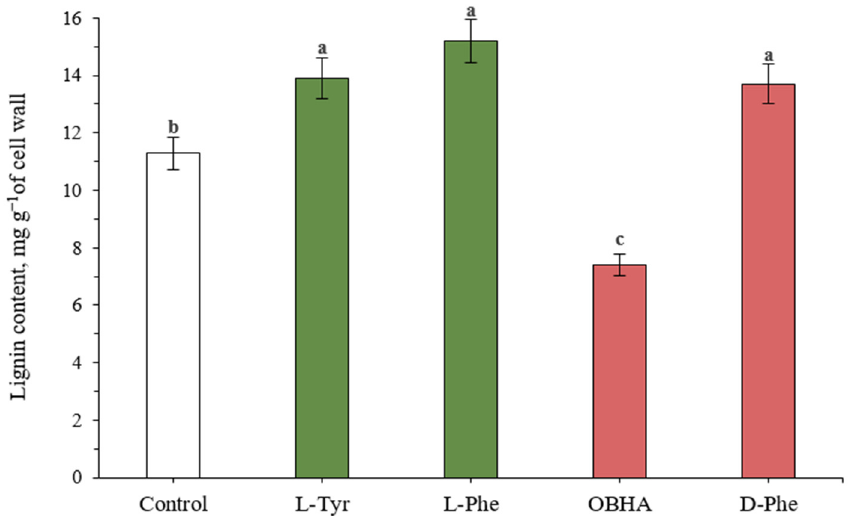
Figure 4. Lignin content in wheat samples incubated on a nutrient medium supplemented with 500 µ M of active compounds. Bars marked with different letters show significant differences at ( p ≤ 0.05) according to Tukey’s test.